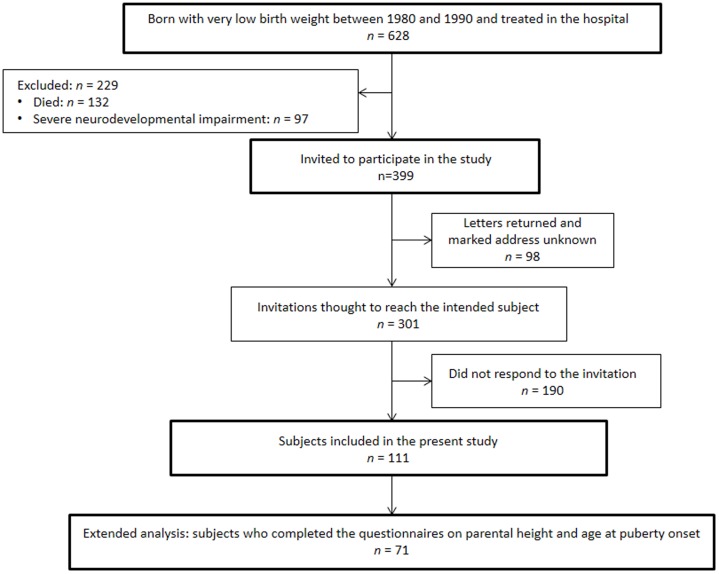
Subject disposition.